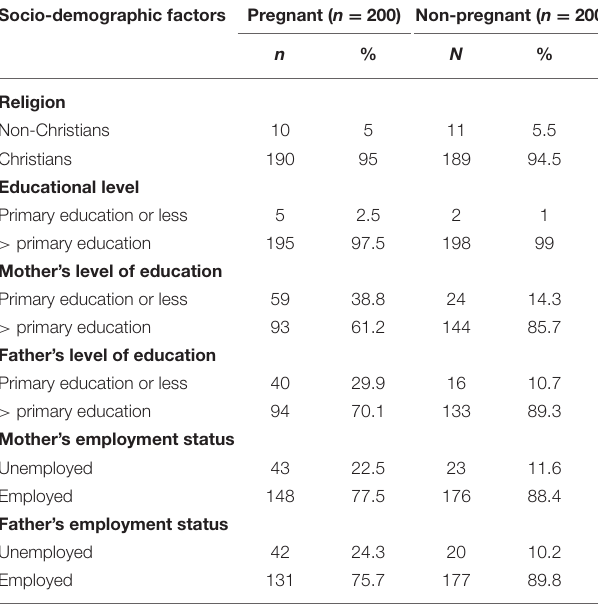
TABLE 1 | Socio-demographic characteristics of respondents. TABLE 2 | Bivariate analysis on access to pregnancy prevention information and services and adolescent pregnancy status.